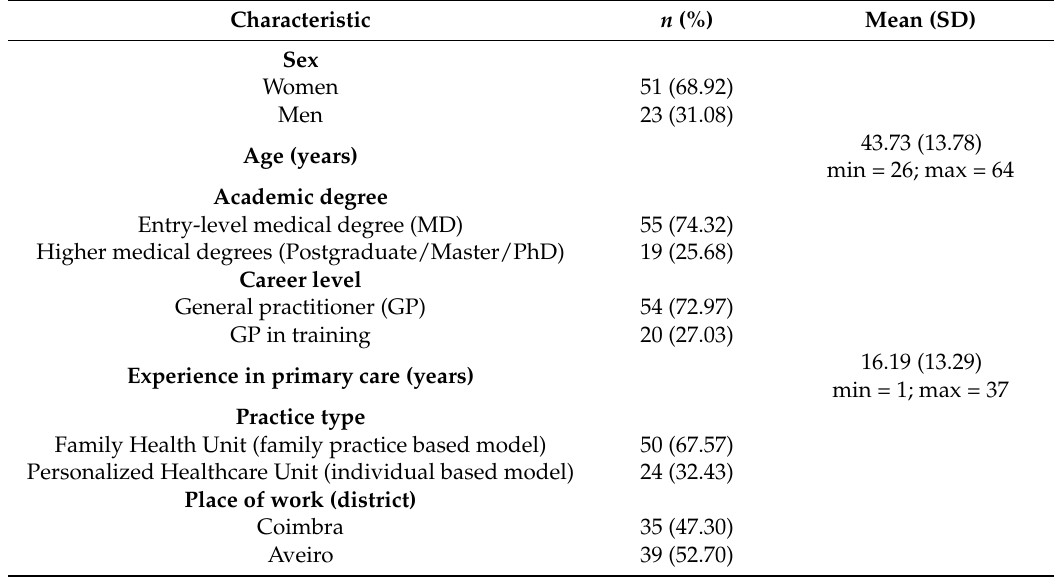
Table 1. Physicians characteristics ( n =